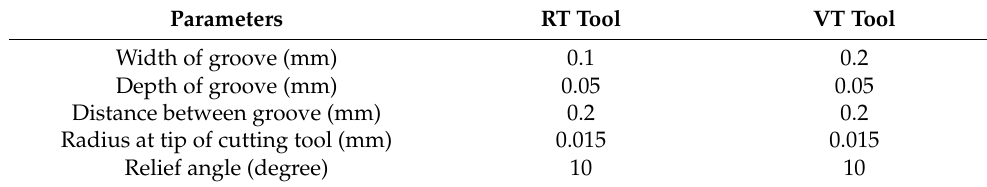
Table 2. Taguchi design parameters for the cutting of work material. Sr. No.